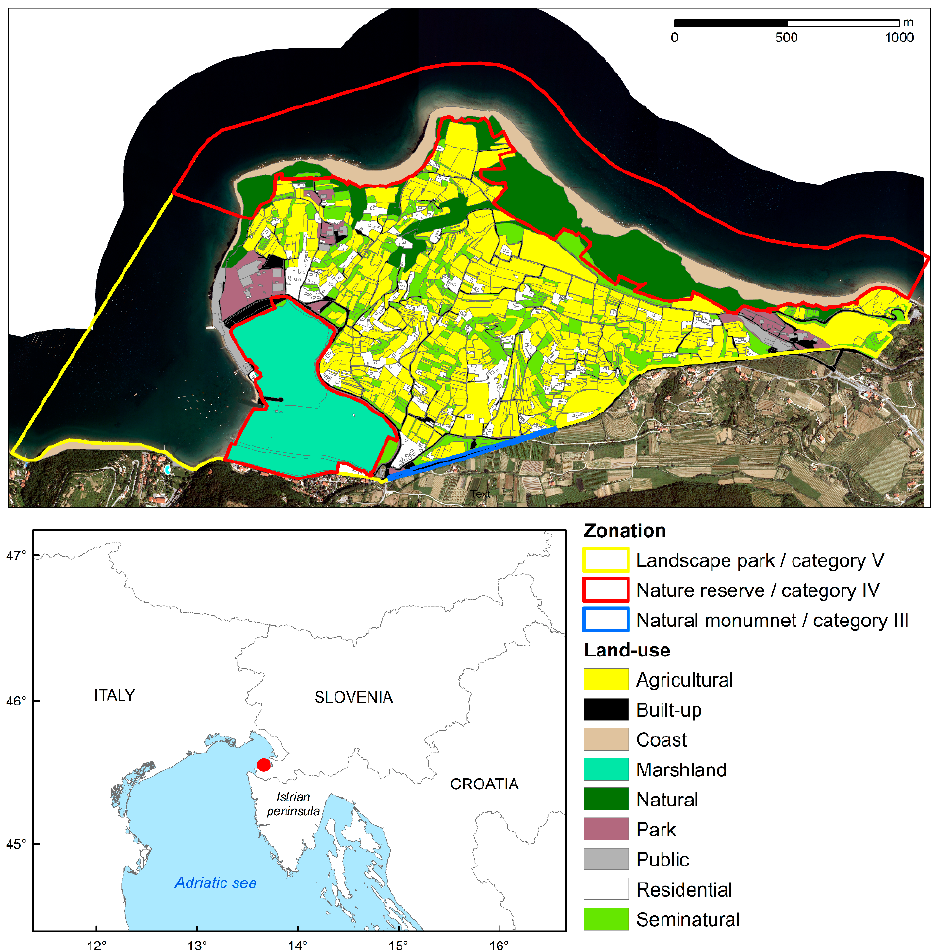
Figure 4. Study area with zonation according to IUCN categories of protected areas and simplified land-use. The red dot indicates the location of the study area within the northern Adriatic region.